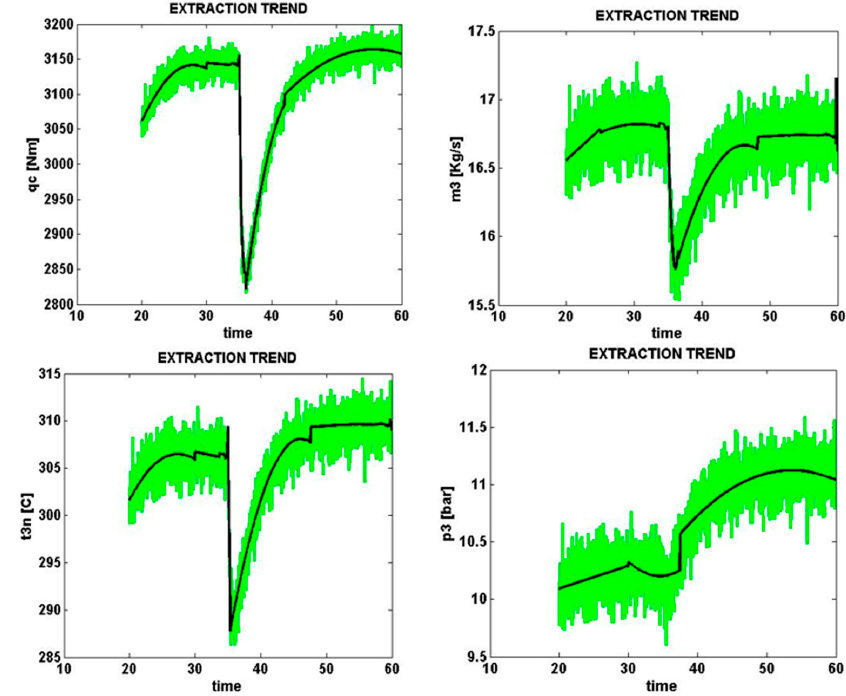
Figure 13. Error caused by solar cell damage, zero percent error (normal).